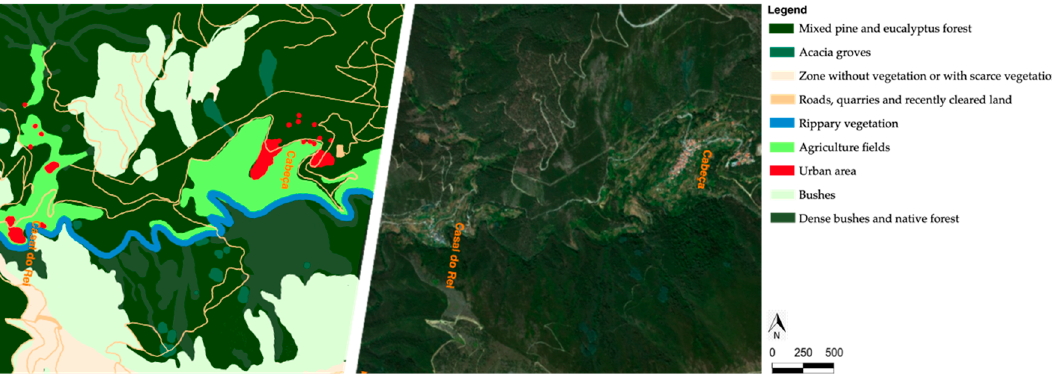
Figure 5. Current land cover in the study area.